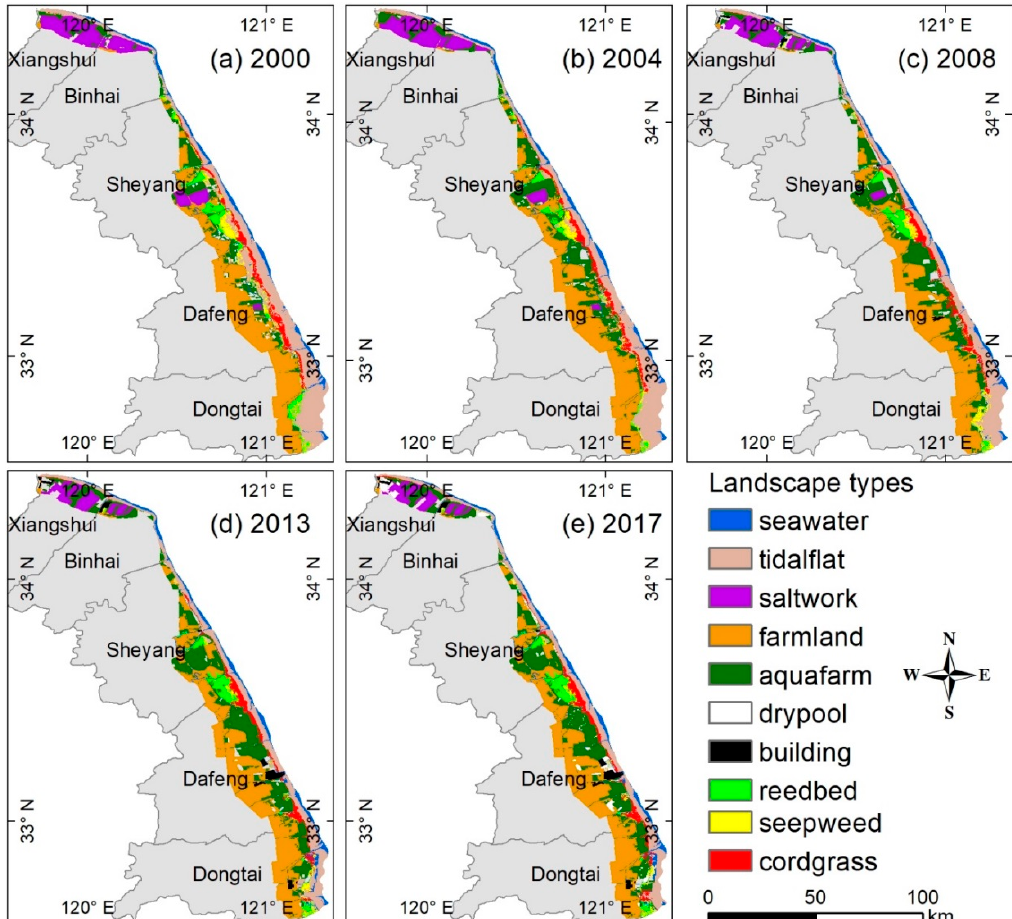
Figure 4. Landscape classification during five periods from 2000–2017 in the open coastal wetlands in Jiangsu, China. ( a ) Map of landscape types in the year 2000; ( b ) map of landscape types in the year 2004; ( c ) map of landscape types in the year 2008; ( d ) map of landscape types in the year 2013; ( e ) map of landscape types in the year 2017.